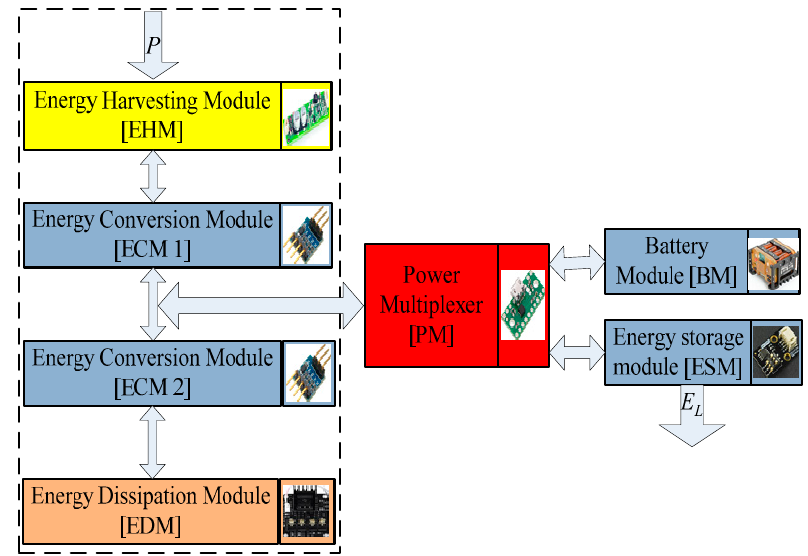
Figure 15. Electromagnetic energy harvesting system using an additional battery [75].